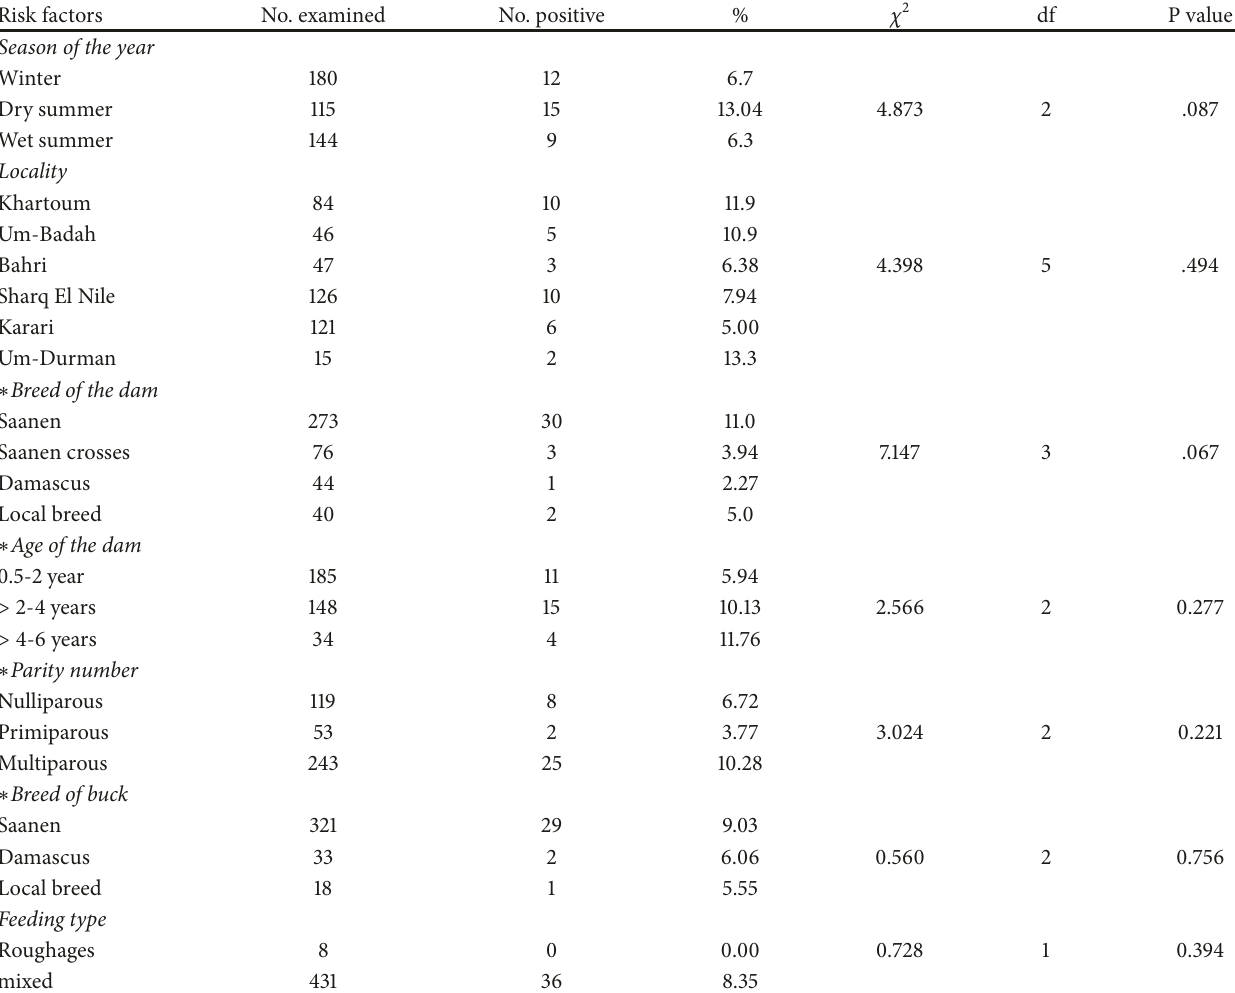
Table 1: Univariate analysis of associated risk factors with fetal death in 439 pregnant goats using chi-square